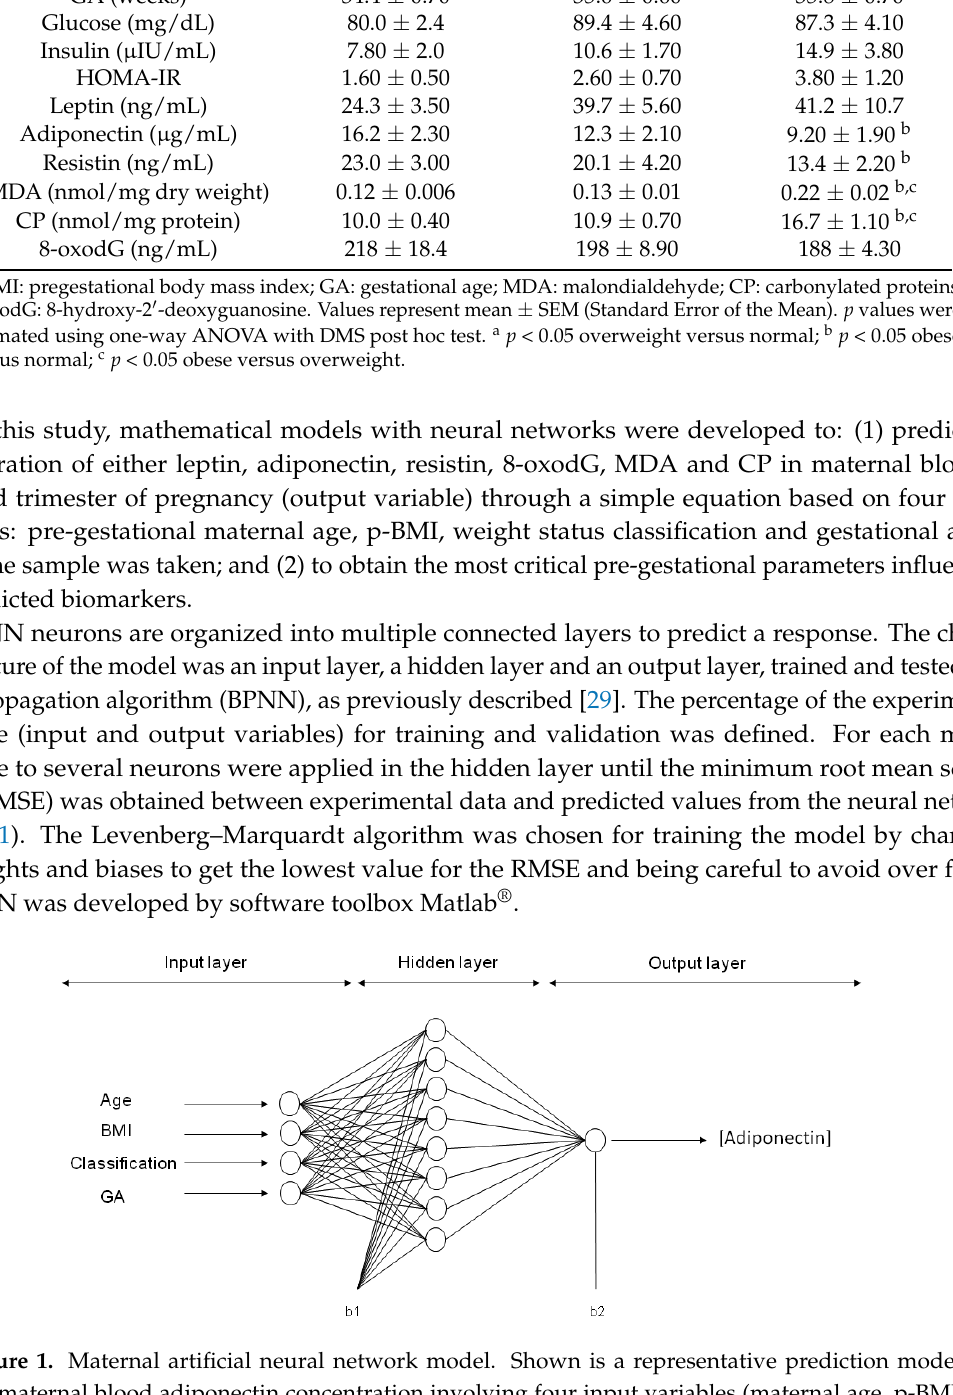
Table 1. Clinical characteristics and biochemical data in peripheral maternal blood classified according to pre-gestational BMI.